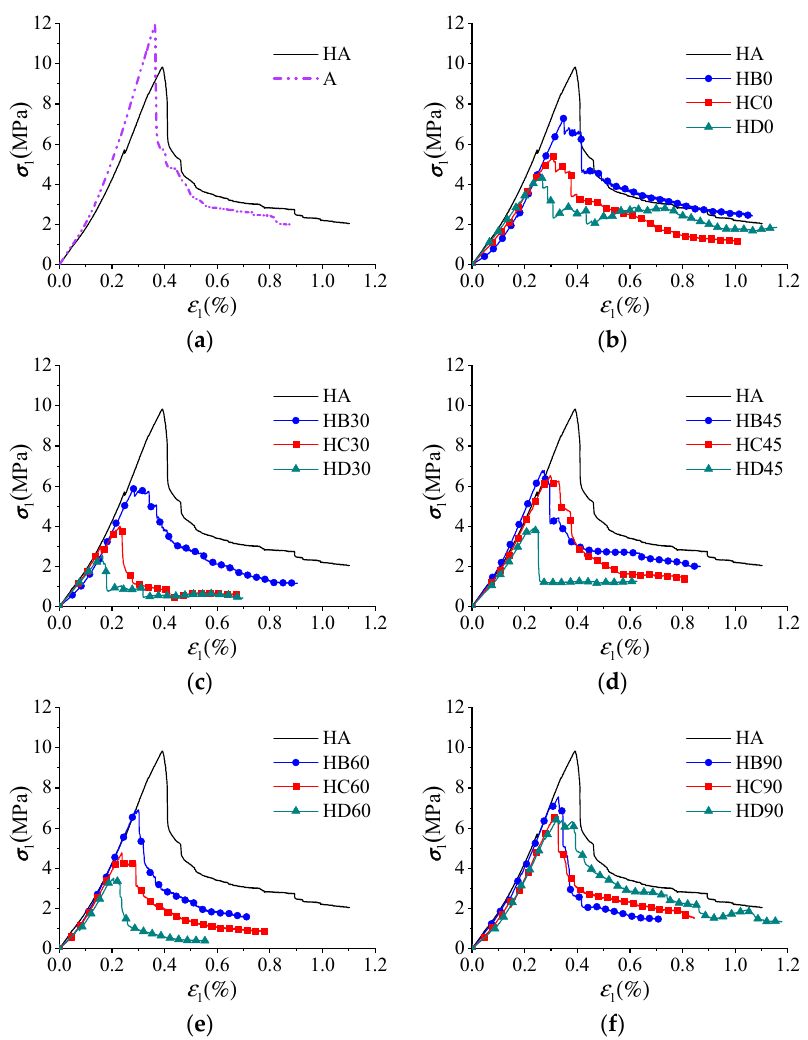
Figure 3. Axial stress–strain curves of all specimens by laboratory tests. ( a ) A and HA; ( b ) β = 0°; ( c ) β = 30°; ( d ) β = 45°; ( e ) β = 60°; ( f ) β = 90°. The peak strength σ p of specimens A and HA are 11.94 MPa and 10.14 MPa, respec- tively, and Young’s moduli E (the tangent modulus in the linear elastic stage of an axial stress–strain curve) of the two specimens are 3.84 GPa and 3.02 GPa, respectively. Figures 4 and 5 show the variation of σ p and E with the two geometrical parameters, i.e., the joint inclination angle β and the joint continuity factor k . It can be seen that: (1) the peak strength and Young’s modulus of the specimen may decrease significantly in the presence of the hole and the non-persistent open joints; (2) for each value of k , the curves of σ p vs. β and E vs. β are W-shaped or V-shaped with the minima and maxima occurring at β = 30° and 90°, respectively; (3) for a constant value of β , the peak strength σ p and Young’s modulus E will decrease with increase in the joint continuity factor k , and the fastest and slowest velocity occurs at β = 30°and β = 90°, respectively. Figure 4. The peak strength vs. two geometrical parameters of the laboratory tests. ( a ) σ p vs. β ; ( b ) σ p vs. k.